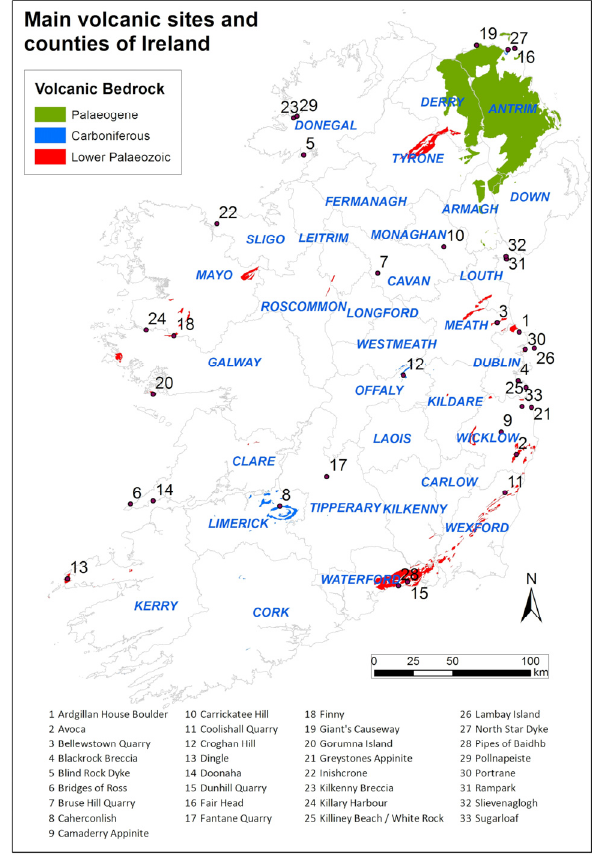
Figure 1. Location of counties and main volcanic sites in Ireland.